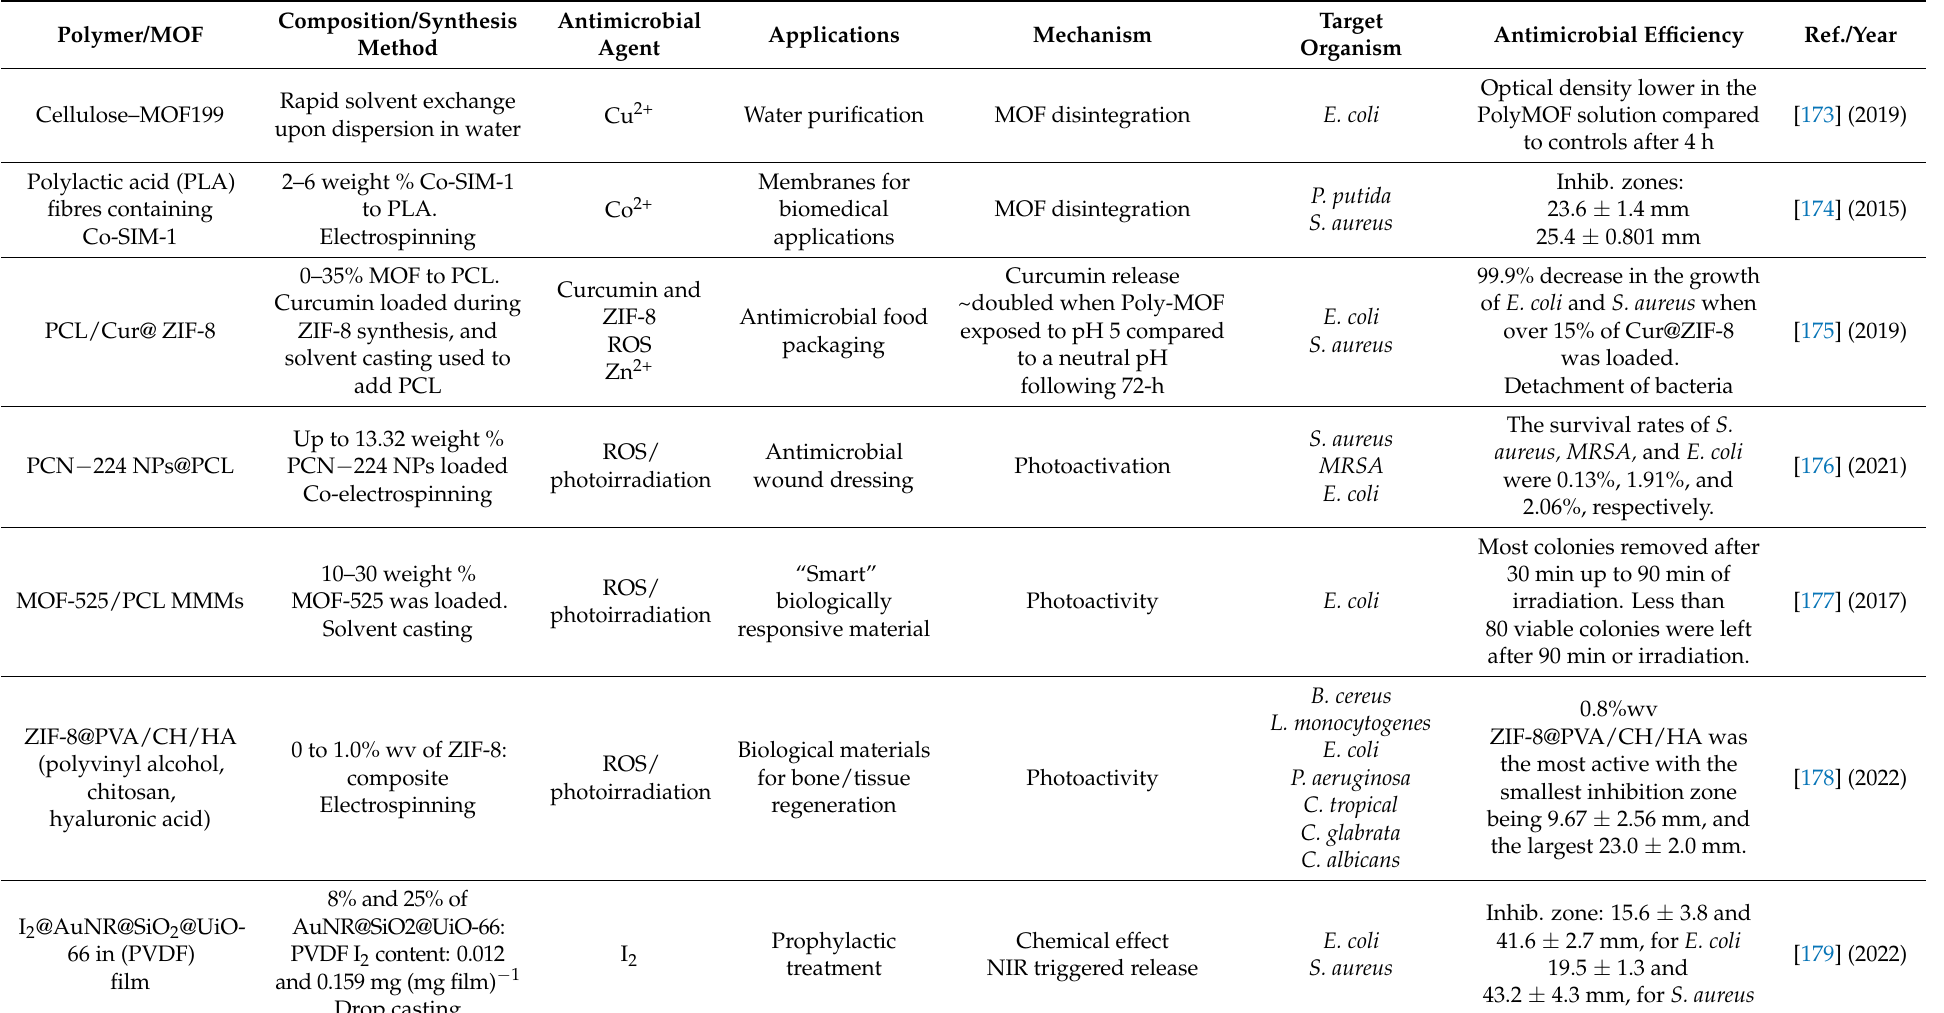
Table 2. Summary of MOF–polymer composites for antimicrobial